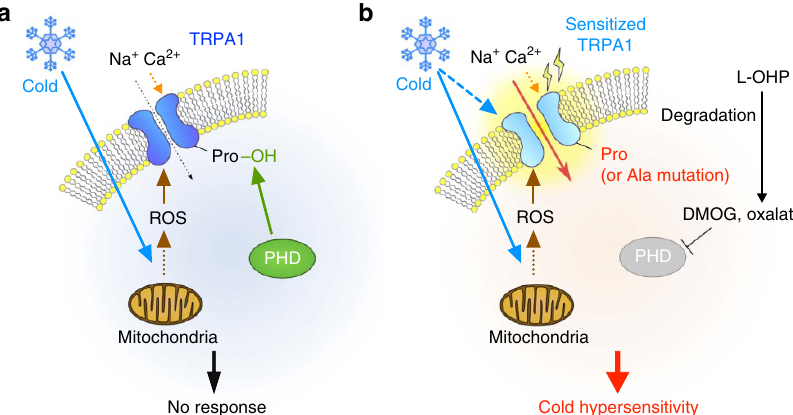
Figure 7 | Consequence of PHD inhibition-triggered TRPA1-mediated cold hypersensitivity. ( a ) Cold triggers ROS generation, but cold is insufficient to activate TRPA1 with conserved PHD-mediated hydroxylation of a proline residue. ( b ) Inhibition of PHD (or mutating the proline residue to alanine) enhances the sensitivity of TRPA1 to ROS. This enhanced sensitivity enables TRPA1 to sense cold-evoked ROS, which causes cold hypersensitivity. The dotted arrows indicate the indirect or